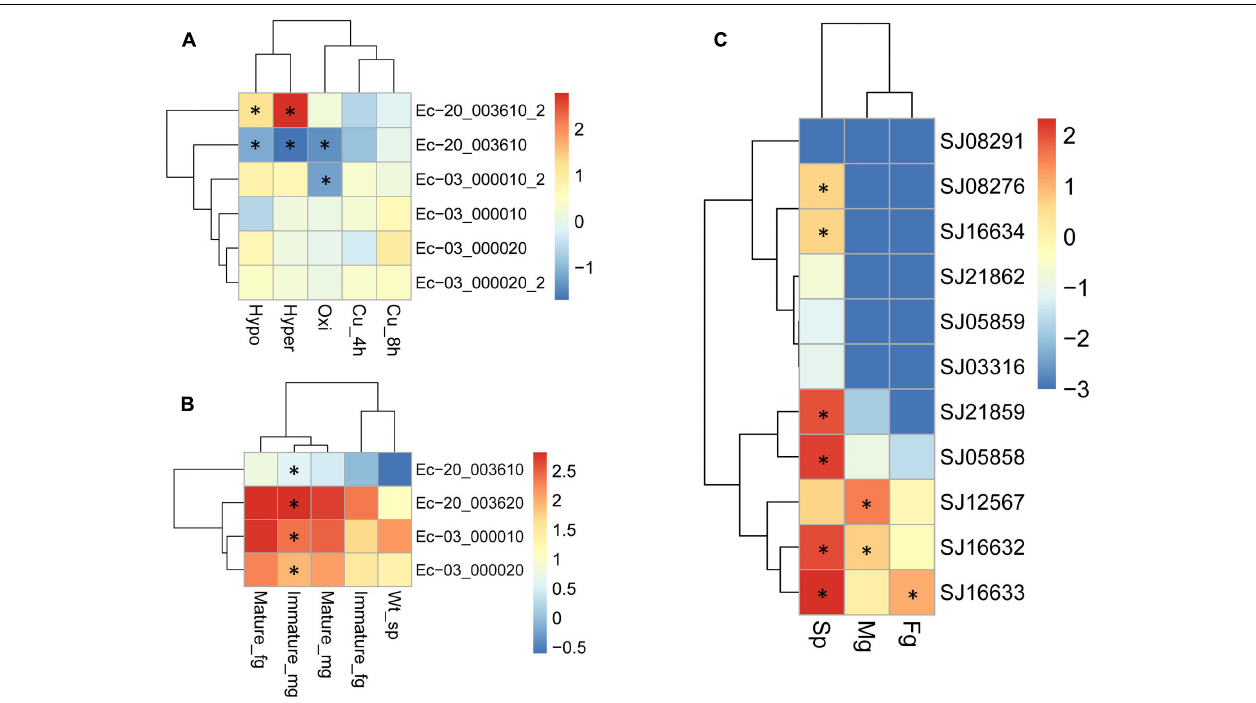
FIGURE 8 | Expression profiles of LOX genes in E. siliculosus (A,B) and S. japonica (C) respectively. (A) Log2-transformed fold changes of expression levels compared to the control. Black star indicates the log2 values of fold changes (treatments/control) > 1.0 or < − 1.0. (B) Log10-transformed RPKM values. Black star indicates the sex-biased expression compared between male and female gametophytes (fold changes > 2, adjusted p -value < 0.05). (C) Log10-transformed FPKM values. Black star indicates sex-biased or sporophyte-biased expression (fold changes > 2, adjusted p -value < 0.05). sp, sporophytes; fg, female gametophytes; mg, male